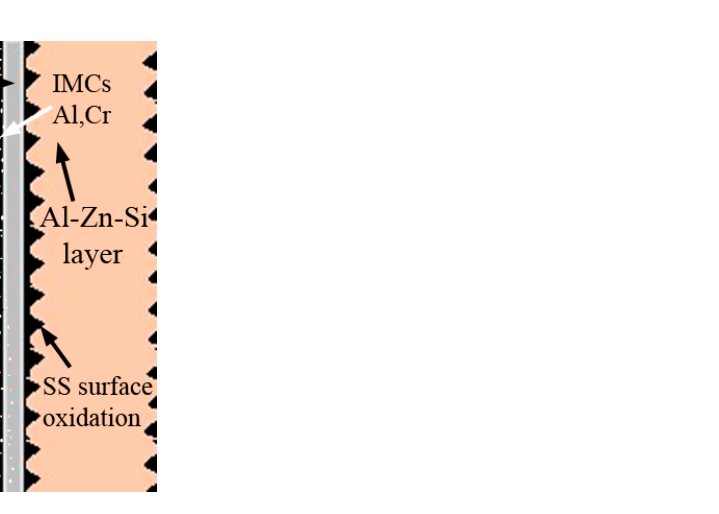
Figure 15. A schematic illustration of IMC layers formation during SS immersion in the Al-Zn-Si coating alloy.